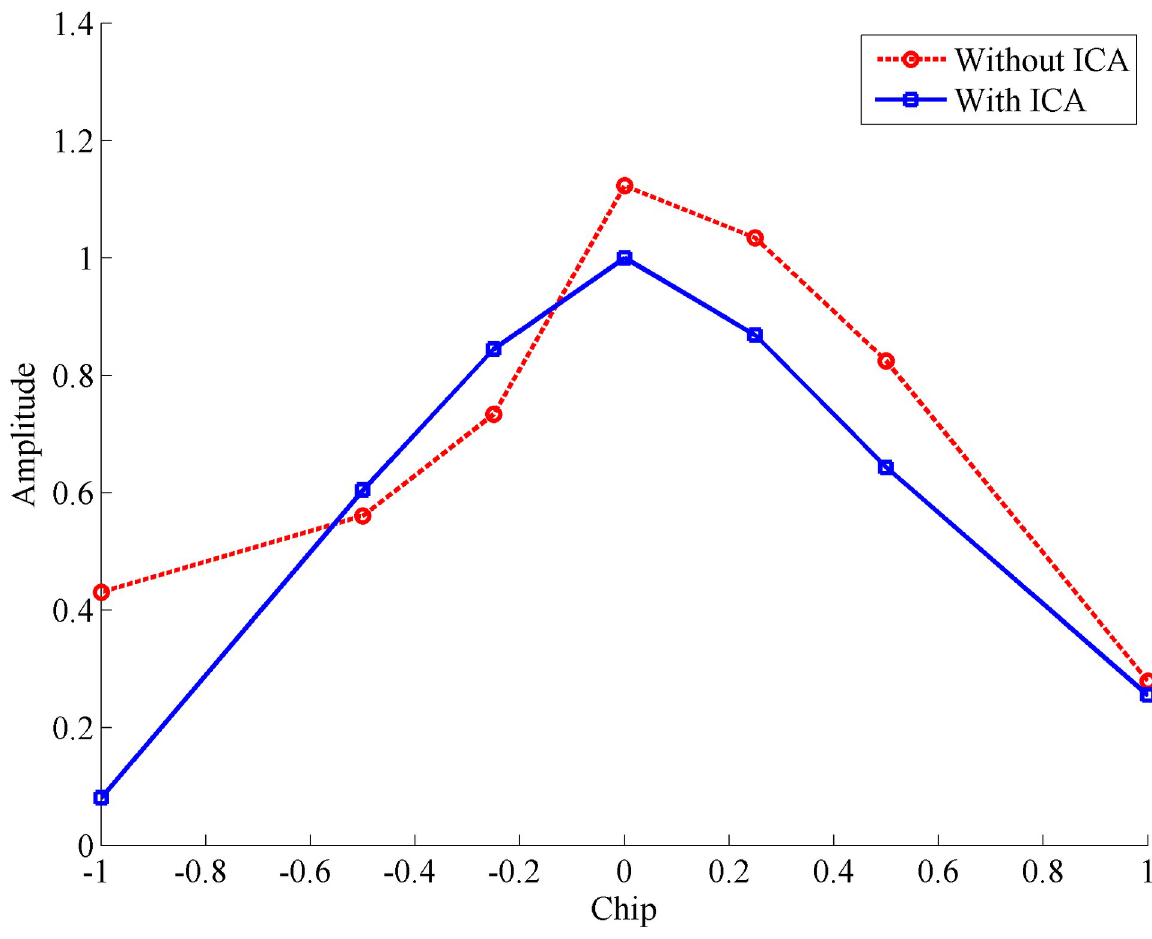
Fig 3. Comparison of code phase